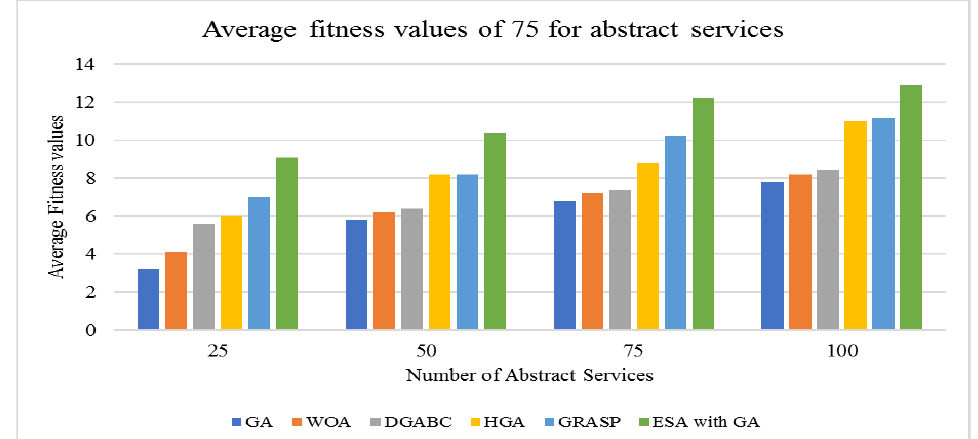
Figure 14. Best average fitness values for 75 abstract services.